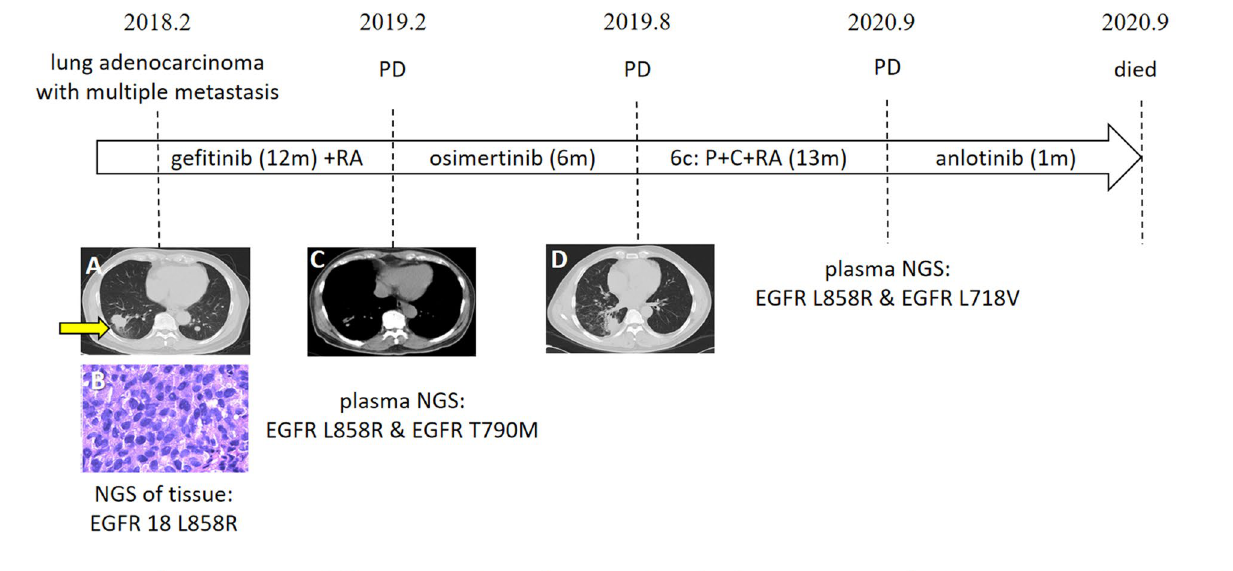
Fig. 2 Detailed diagnosis and treatment procedures of Case2. The patient was revealed a lung occupying lesion through health examination on, and February 6, 2018. The primary tumor located in the right lower lung was punctured under CT guidance ( A ), and the pathologic diag- nosis was adenocarcinoma ( B ) with multi bone metastasis. The next generation sequencing (NGS) results of the tissue indicated the pres- ence of the L858R mutation of EGFR exon 21. Gefitinib was administered in combination with radiotherapy to the left scapula. The symp- toms of ostalgia and thoracalgia rapidly improved, and the best response achieved was PR. CT re-examination in February 2019 indicated PD status ( C ) in focus of lung and bone. Lumbar disc arthroplasty was performed to protect the lumbar spine and relieve pain. In the wake of the presence of EGFR T790M mutation (c.2369C > T(p.T790M), 2.0%) plus EGFR L858R mutation (c.2573 T > G(p.L858R), 5.2%) detected by NGS of the plasma, Osimertinib was subsequently applied for six months. In August 2019, CT once again indicated PD status ( D ) and pem- etrexed plus carboplatin was applied for six cycles in combination with radiotherapy to left hip. The best efficacy assessment achieved PR. In view of the progressed bone metastases and the significantly increased serum concentration of tumor markers in September 2020, plasma NGS was performed, revealing the presence of the EGFR L718V mutation (C.2152C > G(p.L718V), 13.9%). The patient was treated with anlo- tinib and died on September 20,